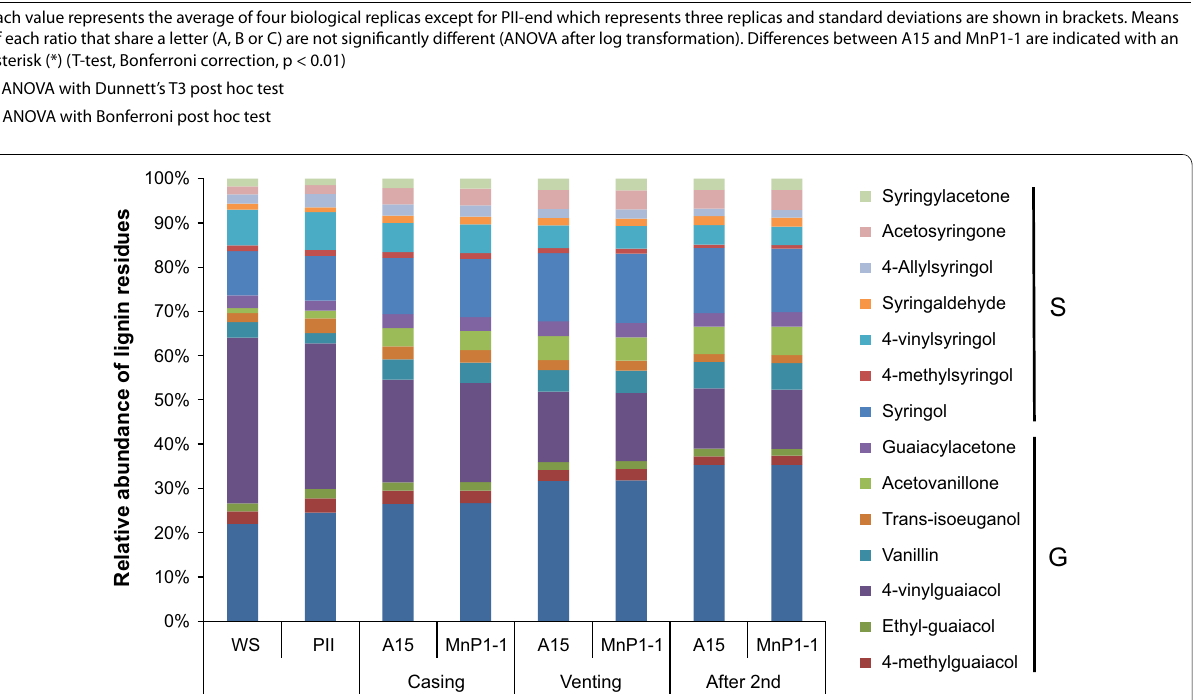
Fig. 3 Relative abundance of lignin derived residues as measured by pyrolysis-GC/MS in compost samples of a semi-commercial cultivation of A15 and the MnP overexpressor MnP1-1. Each compost sample represents the average of biological quadruplicates. Error bars have been left out for clar- ity, all values are available in Additional file 1: Table S3. WS wheat straw, PII compost from end of phase II Table 2 Carbohydrate composition, degree of substitution, and total carbohydrate content of compost colonized by A15 or strain